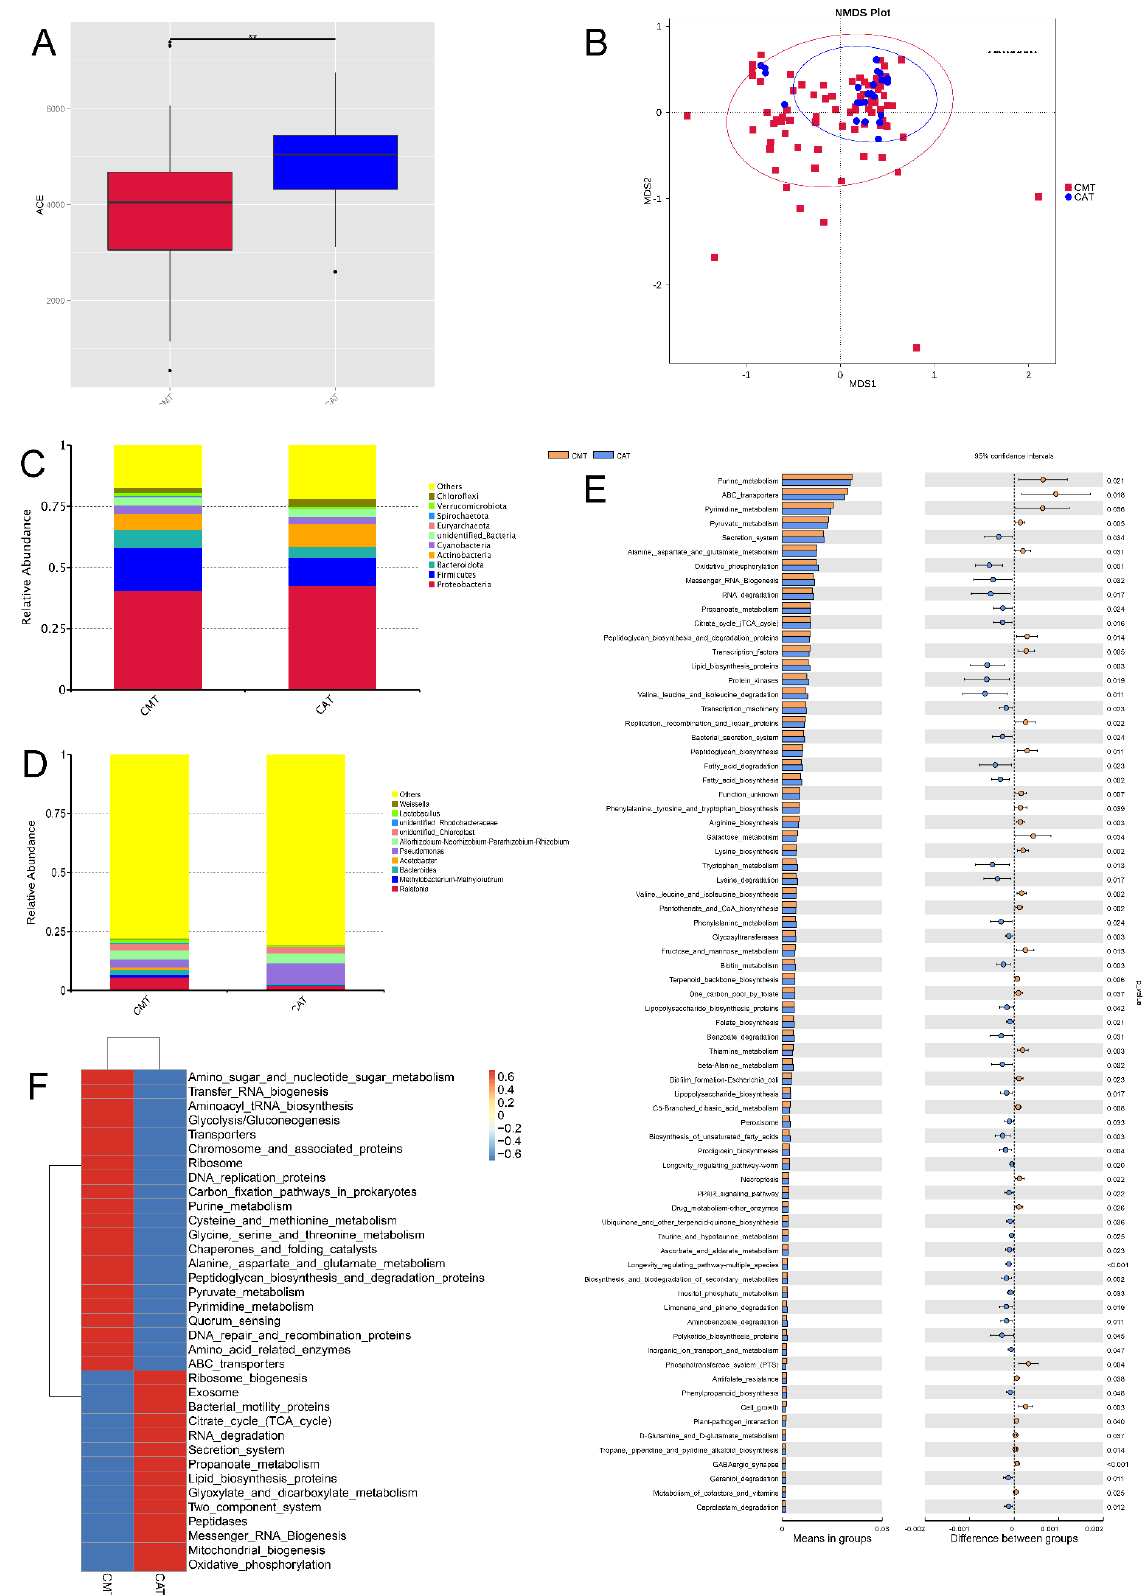
Figure 2. Comparisons of microbiota diversity between canine mammary tumor tissues (CMT) and canine tumor-adjacent tissues (CAT). ( A ) Alpha diversity (ACE index) of microbial communities